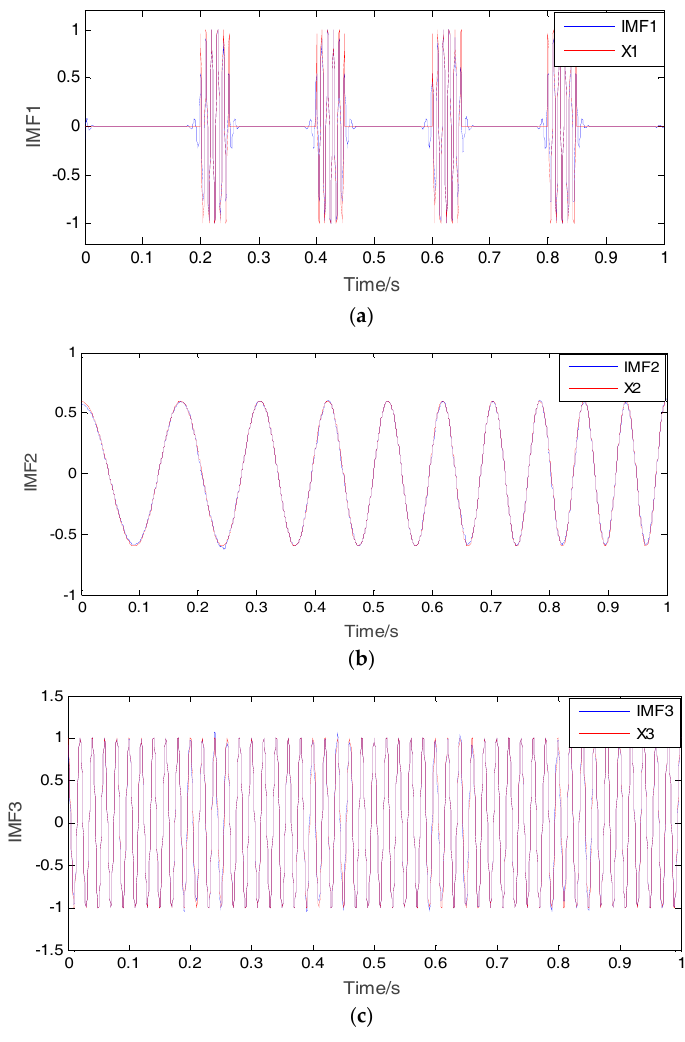
Figure 3. Simulation signal y ( t ) VMD results. (a) IMF1 (b) IMF2 (c) IMF3